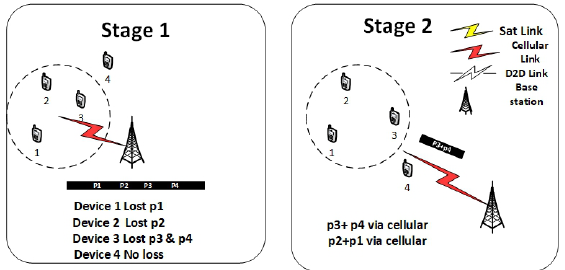
Figure 2. Network coding (Cellular